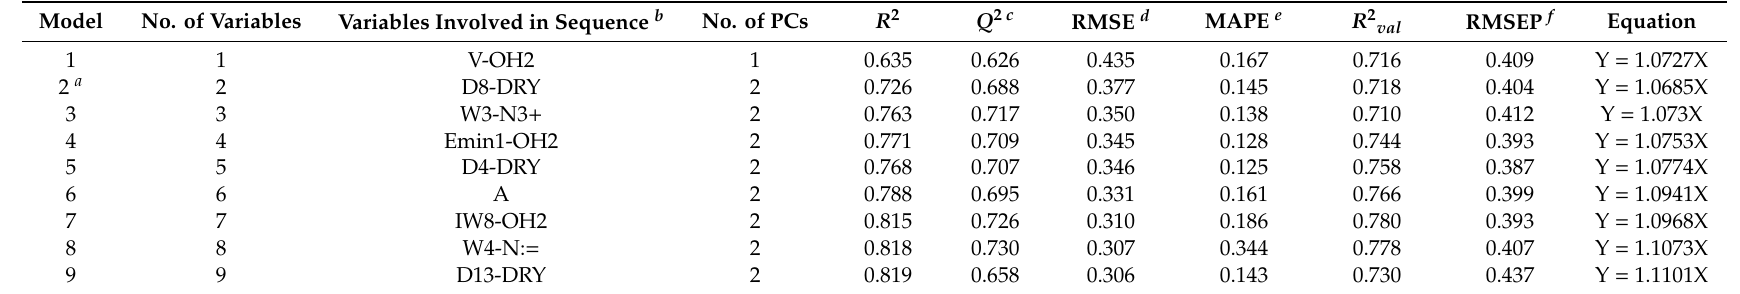
Table 1. The partial least squares (PLS) modeling results of the dissociation rate constants of the Hsp90 inhibitors. Model